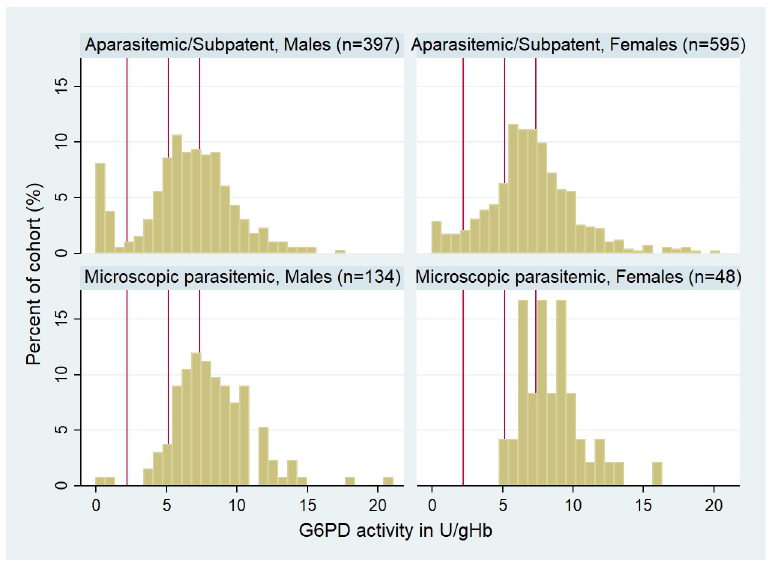
Fig 3. G6PD activity (in U/g Hb) distribution stratified by microscopic parasitemia and sex in the efficacy trial and cross-sectional survey. Red vertical lines indicate 30%, 70%, and 100% G6PD activity of the adjusted male median (from left to right). 100% G6PD activity = 7.4 U/g Hb. Participants with submicroscopic parasitemia included in malaria-negative cohort. G6PD, glucose-6-phosphate